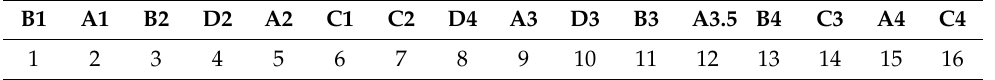
Table 2. Vitapan classical shade guide arranged from lightest to darkest